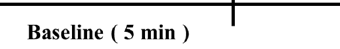
Figure 4. Apomorphine (APO) or Saline-induced protocol.